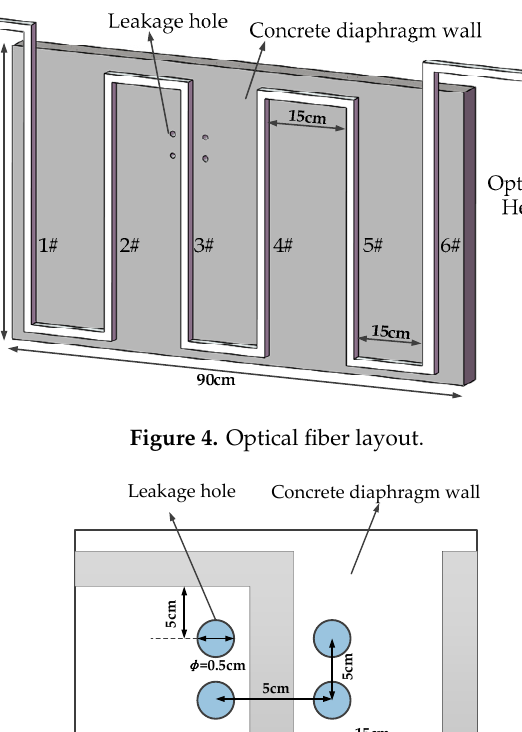
Figure 6. Drawing of the PVC connecting tube. 3.3. Test Process In the preliminary preparation stage, the larger particles in the model box were removed, the silty clay surface was smoothed, the concrete wall was placed, and the same silty clay as the model box was added to the PVC pipe. According to the optical fiber burial method described above, the optical fiber was laid in an "S" shape. In the course of laying the fiber, it is necessary to ensure that the temperature measuring optical fibers are tightly bundled with the heating optical cables. The optical fibers were then tested. Then we connect the optical fiber with the DTS and set the coordinates. The optical fibers were fixed. After the temperature measuring optical fibers, heating cables and leakage points were basically in the same horizontal plane, soil was slowly added to the model box to the designated level. During the process of soil addition, attention should be paid to the protection of the optical fibers. The heating power of cable was set to 4, 6, 8, 10 and 12 W/m. According to Ohm's law: